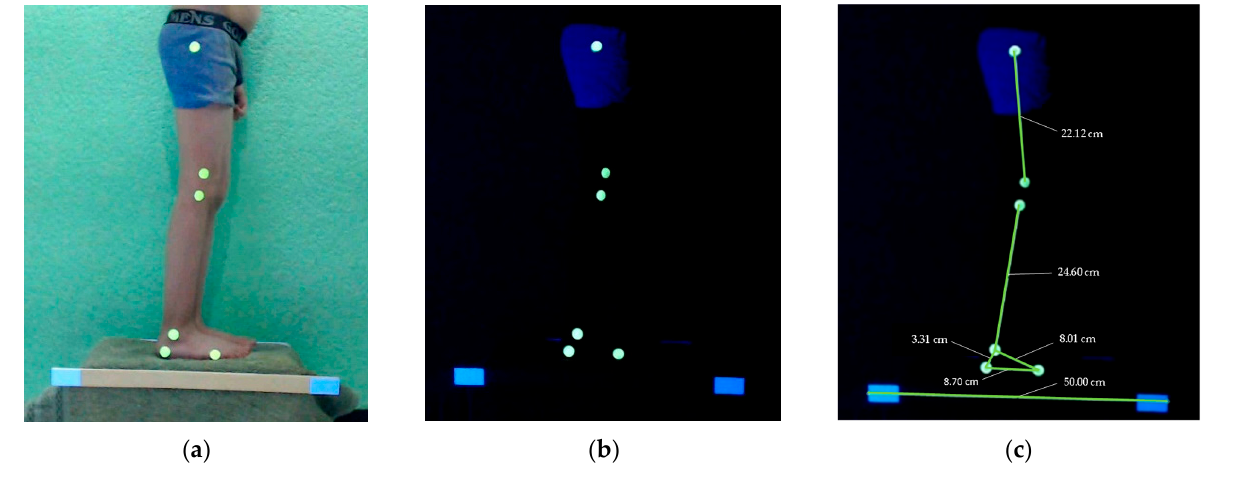
Figure 8. Image to be analysed in the Kinovea program: ( a ) image captured based on the participant’s test area, ( b ) image captured using a blacklight, ( c ) result of the analysis in Kinovea.